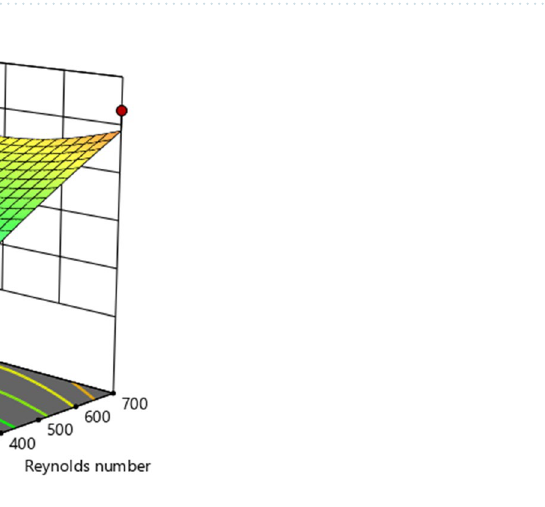
Figure 13. Estimation of the Nusselt number against the Reynolds number in a minichannel heat sink with TiO 2 /water nanofluid and distilled water.